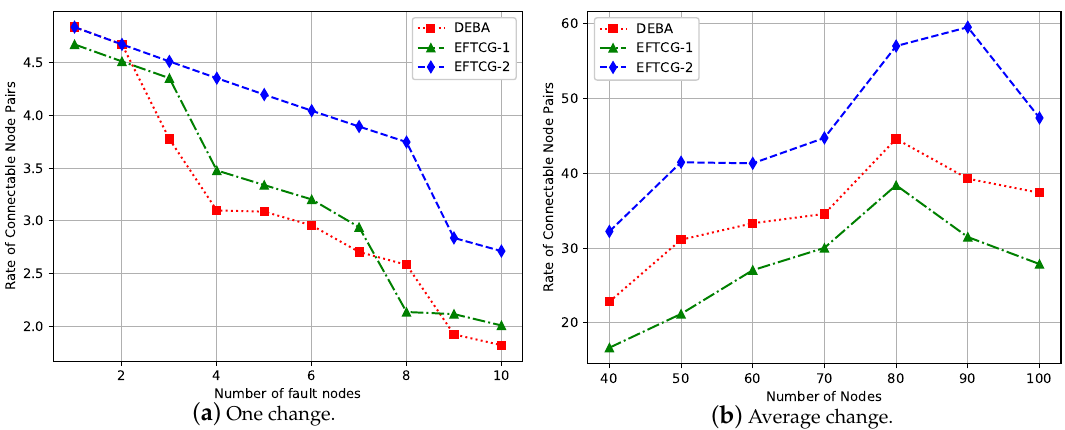
Figure 13. The rate of connectable node pairs, ( a ) the change of the rate of connectable node pairs with the generation of failure nodes when the number of nodes is 100; ( b ) the change of the rate of connectable node pairs under different node density after 10 failure nodes appear.